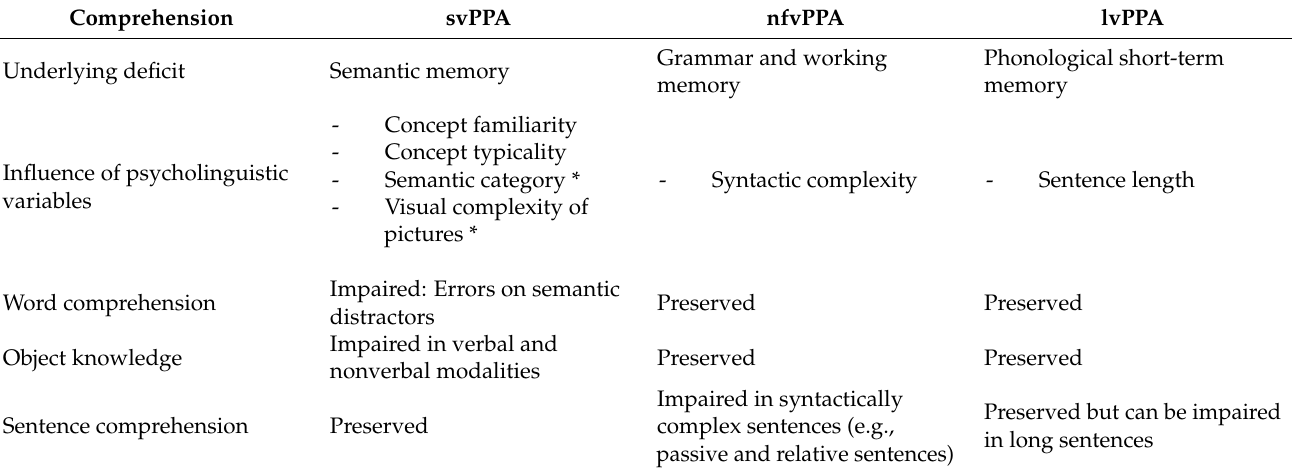
Table 2. Underlying cognitive deficits and salient characteristics of comprehension disorders in the three PPA